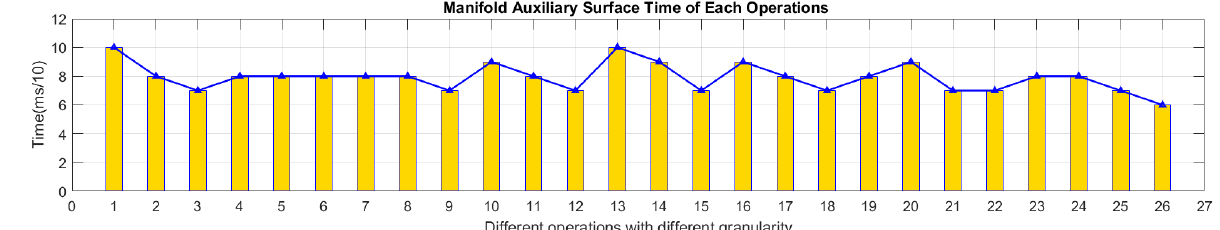
Figure 10. Times for samplings calculation at different